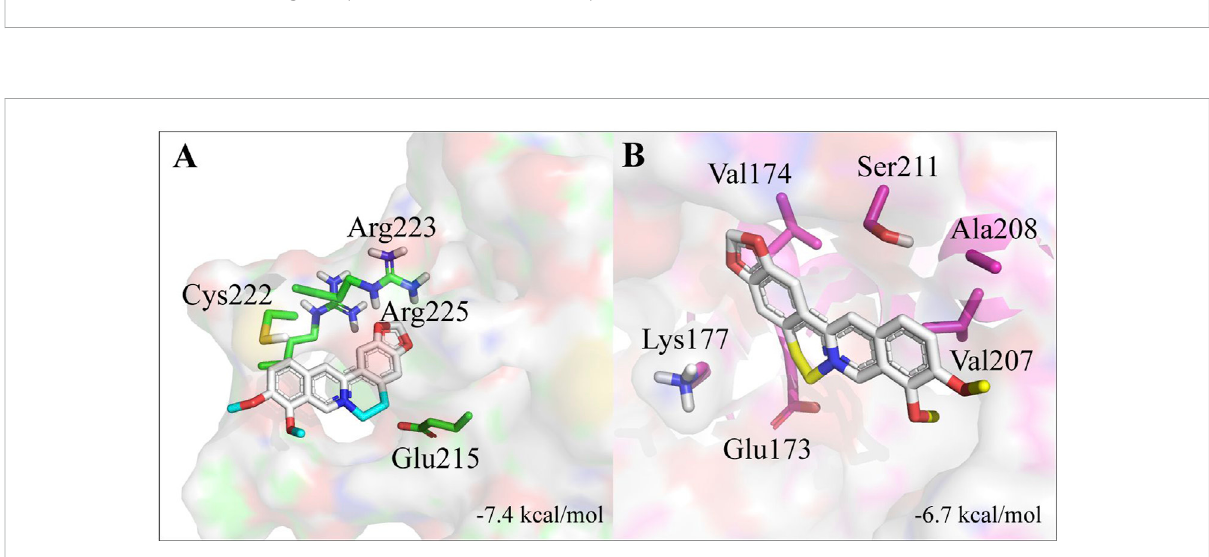
FIGURE 4 Homology models for GST8 and GST20. (A) 3D structure of GST8. (B) 3D structure of GST20. Residues from predicted active sites and close to berberine, are